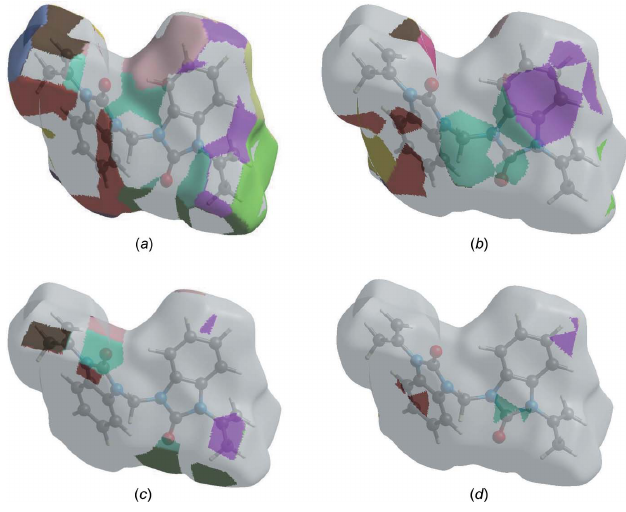
Figure 7 The Hirshfeld surface representations with the function d norm plotted onto the surface for ( a ) H (cid:2)(cid:2)(cid:2) H, ( b ) H (cid:2)(cid:2)(cid:2) C/C (cid:2)(cid:2)(cid:2) H, ( c ) H (cid:2)(cid:2)(cid:2) O/O (cid:2)(cid:2)(cid:2) H and ( d ) H (cid:2)(cid:2)(cid:2) N/N (cid:2)(cid:2)(cid:2) H